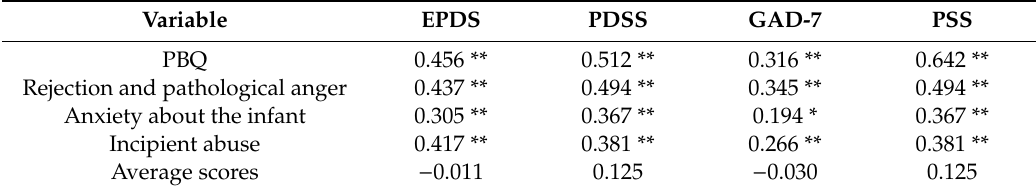
Table 4. Detailed correlation results of PBQ subscales with depression, anxiety and